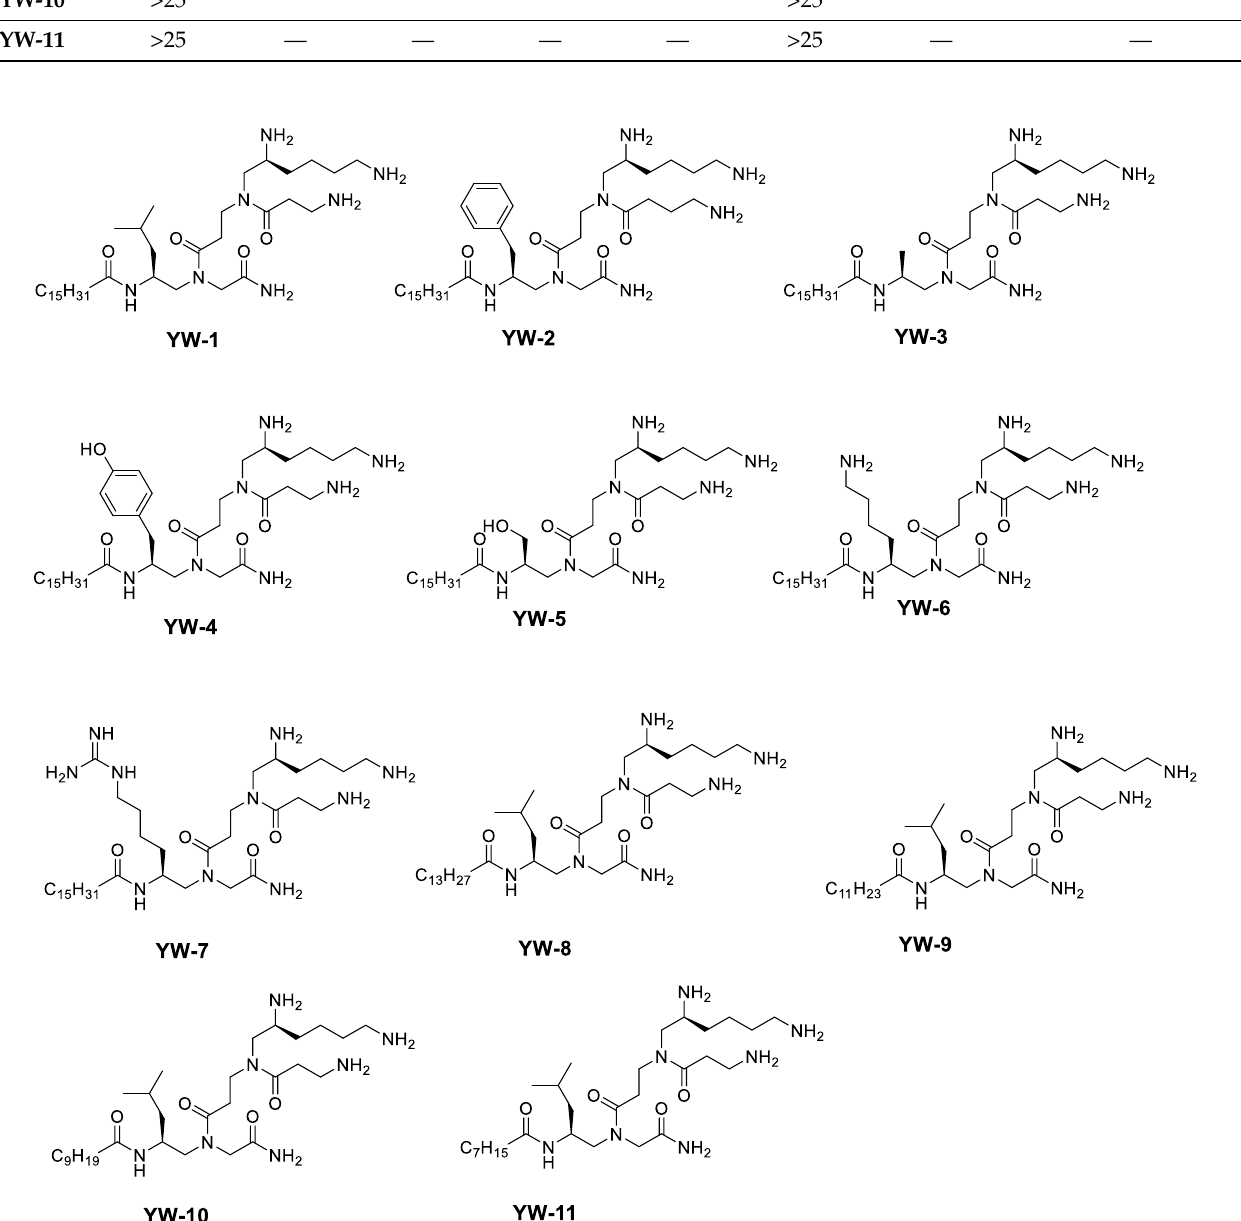
Table 1. Antibacterial activity, hemolytic activity, and selectivity of dendrimeric γ-Aapeptides. “--- ” means not